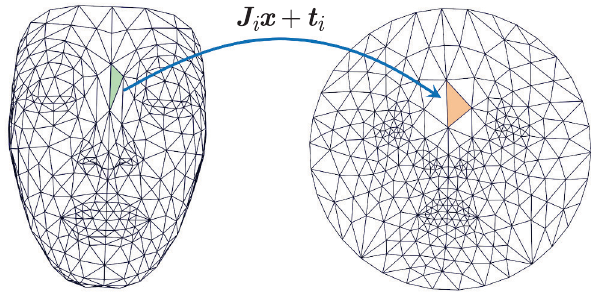
Fig. 2 Illustration for the piecewise linear mapping.